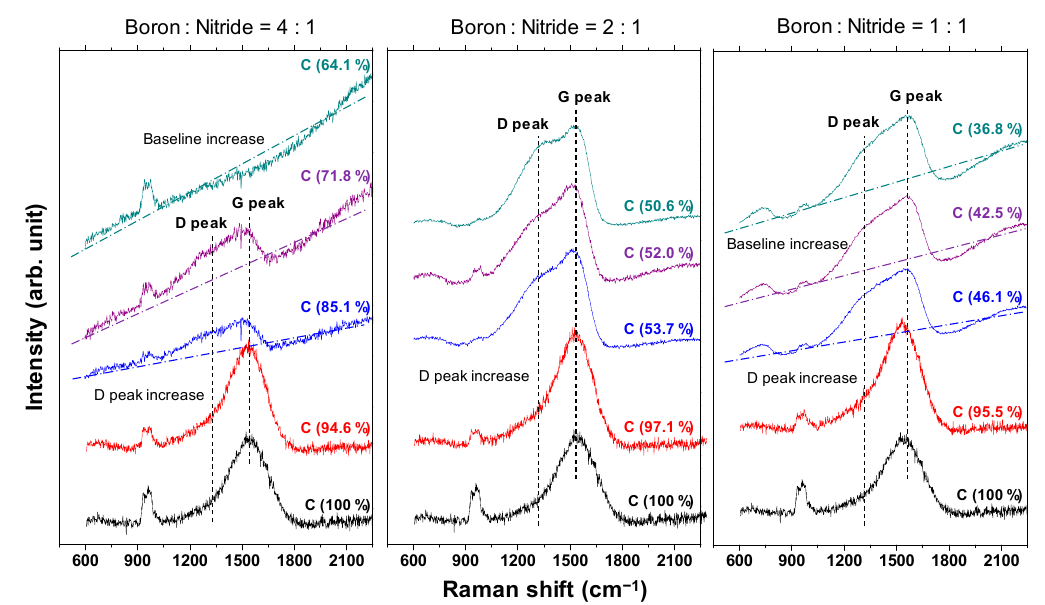
Figure 7. Raman spectra of the a-BCN films.